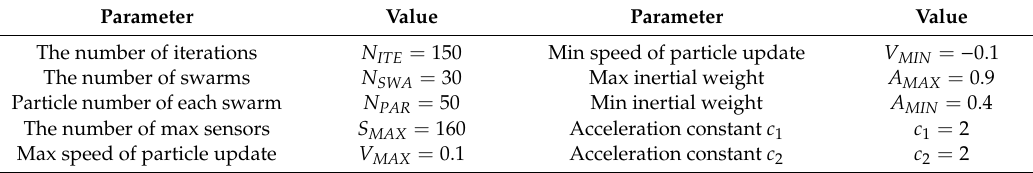
Table 2. Parameters of Algorithm 1 in Figure 13.